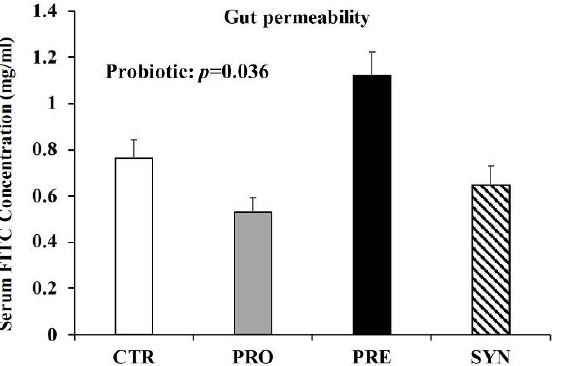
Figure 5. The impact of three-week prebiotic, probiotic, or synbiotic consumption on intestinal permeability, measured as serum FITC-4000 concentration. Values or mean ± SEM, n = 9/group. CTR, control; PRO, probiotic; PRE, prebiotic, SYN, synbiotic.